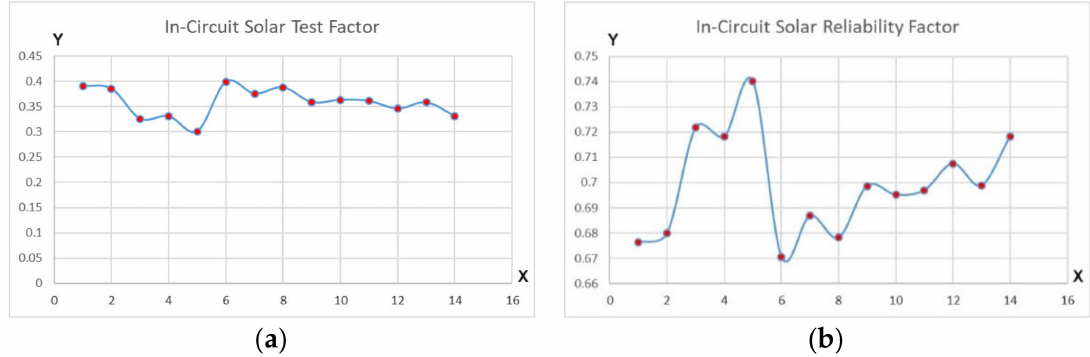
Figure 9. Hybrid testing suite for ICT test scenarios: ( a ) ICT STF generated according to the total number of structural faults; X-axis representing the number of days; Y-axis representing the ICT STF parameter ( b ) ICT SRF generated according to the ICT STF parameter; X-axis representing the number of days; Y-axis representing the hardware SRF parameter; adapted from